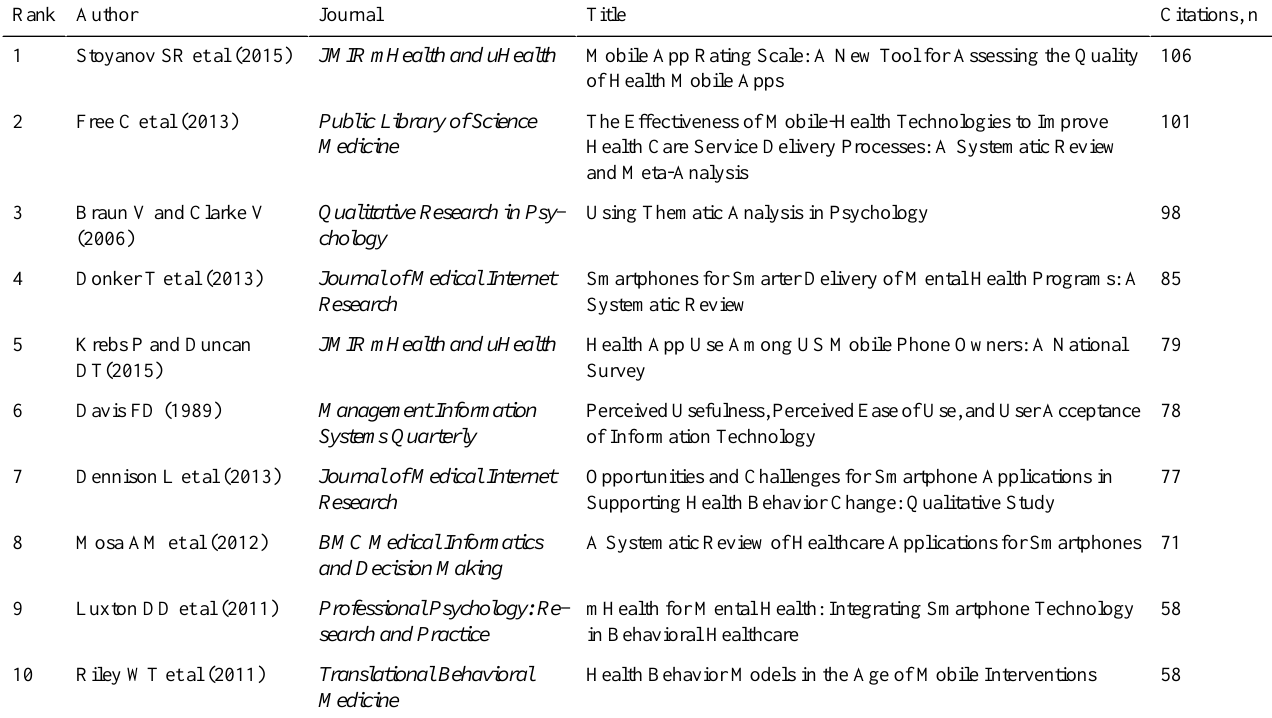
Citations, nTitleJournalAuthorRank